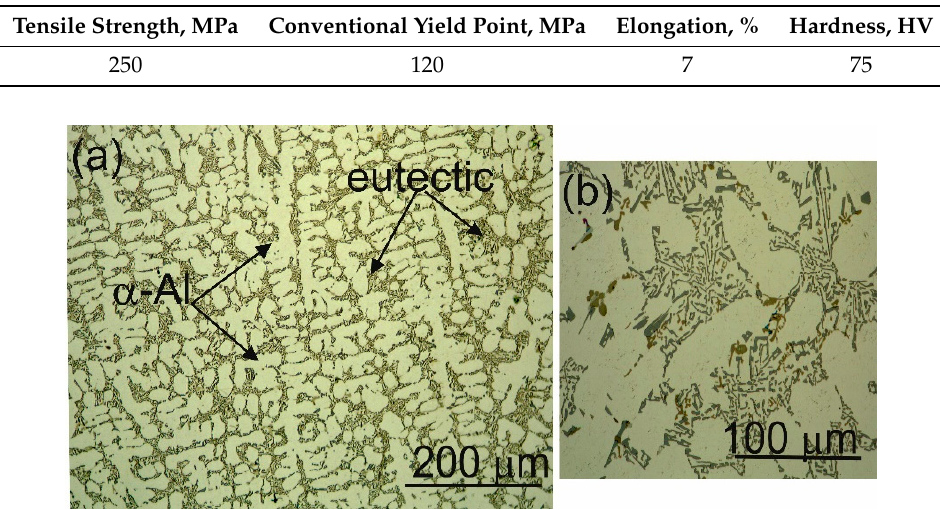
Table 2. Mechanical properties of AlSi9Mg.